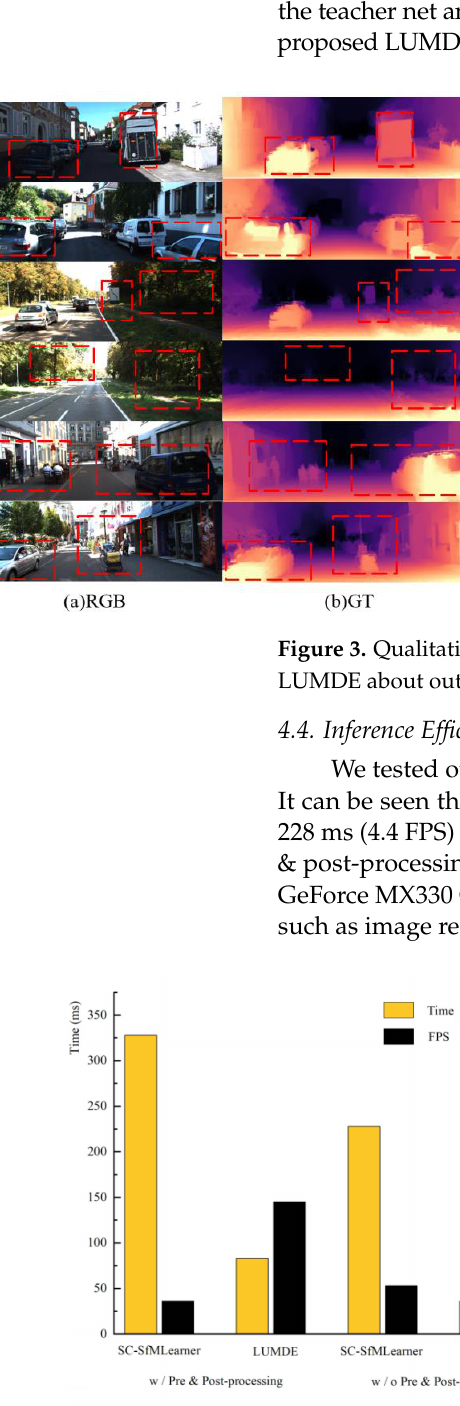
GeForce MX330 GPU. In the inference stage, only the DepthNet is used to test inference effi-